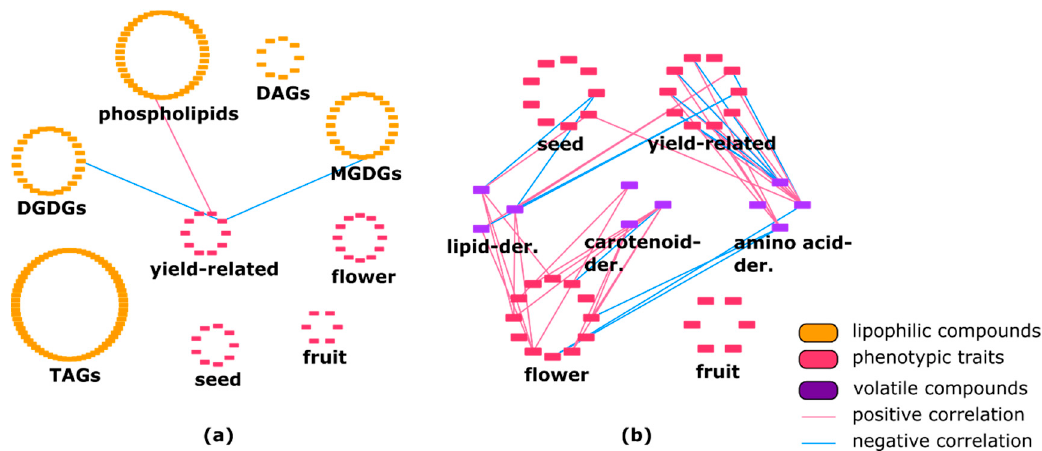
Figure 2. ( a ) Correlation between phenotypic traits and lipophilic compounds in Solanum pennellii introgression-lines (ILs). Yield-related traits showed three connection with several lipid classes such as phospho- and galactolipids. DAG—diacylglycerol; TAG—triacylglycerol; DGDG—digalactosyldiacylglycerol; MGDG—monogalactosyldiacylglycerol. ( b ) Correlation between phenotypic traits and volatiles in S. pennellii ILs. Various phenotypic traits are linked to each volatile class.